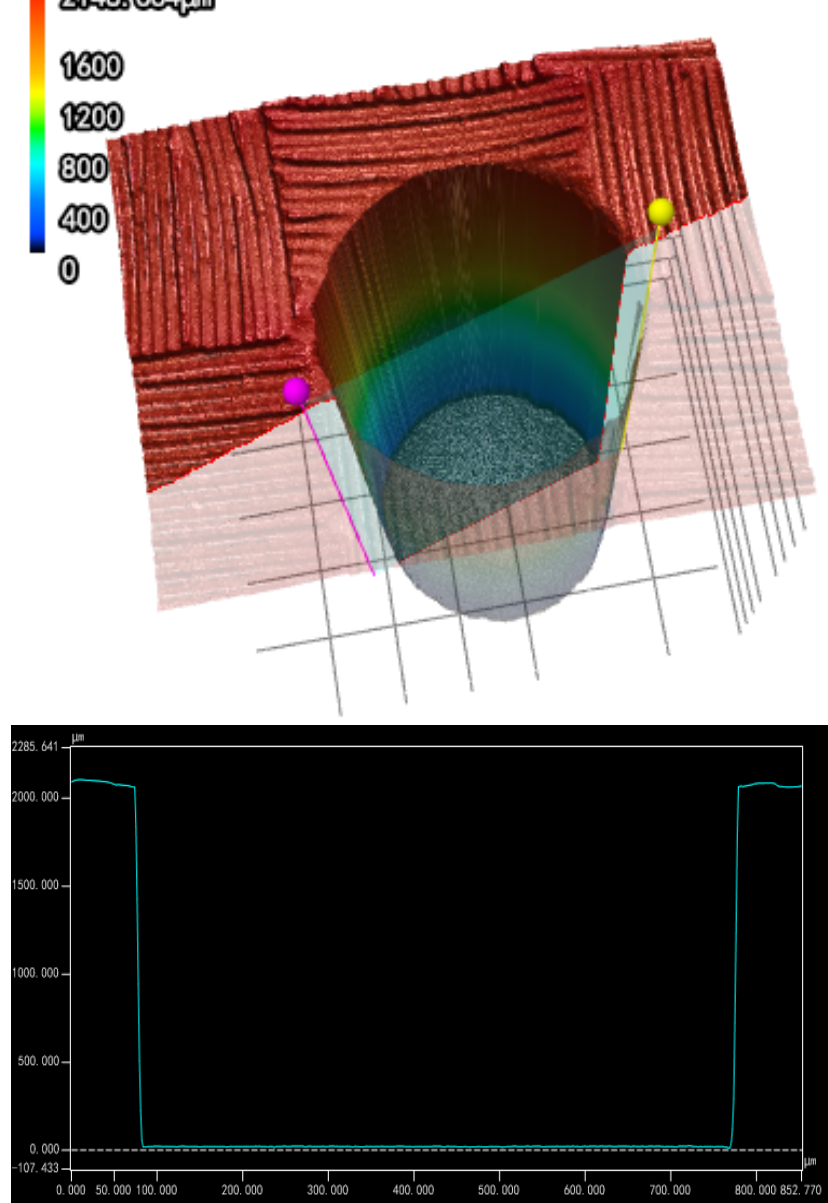
Figure 12. Cross-sectional profile of a cylindrical hole measured by the confocal microscope. In addition, the HAZ was measured using a digital microscope at the entrance and the cross section of the hole. Only small HAZs (< 10 μ m) were found at the entrance, which was better than picosecond laser drilling (< 25 μ m) [13] or nanosecond laser drilling (<50 μ m) [24], and no obvious HAZ at the cross section, as shown in Figures 13 and 14. The HAZ at the entrance of the hole may be caused by the fact that when the laser is fed to the bottom of the hole through the movement of the Z axis, the beam away from the laser focus irradiates the material at the entrance of the hole, and the beam energy of the beam was weak, which cannot remove the material completely. Therefore, most of the energy